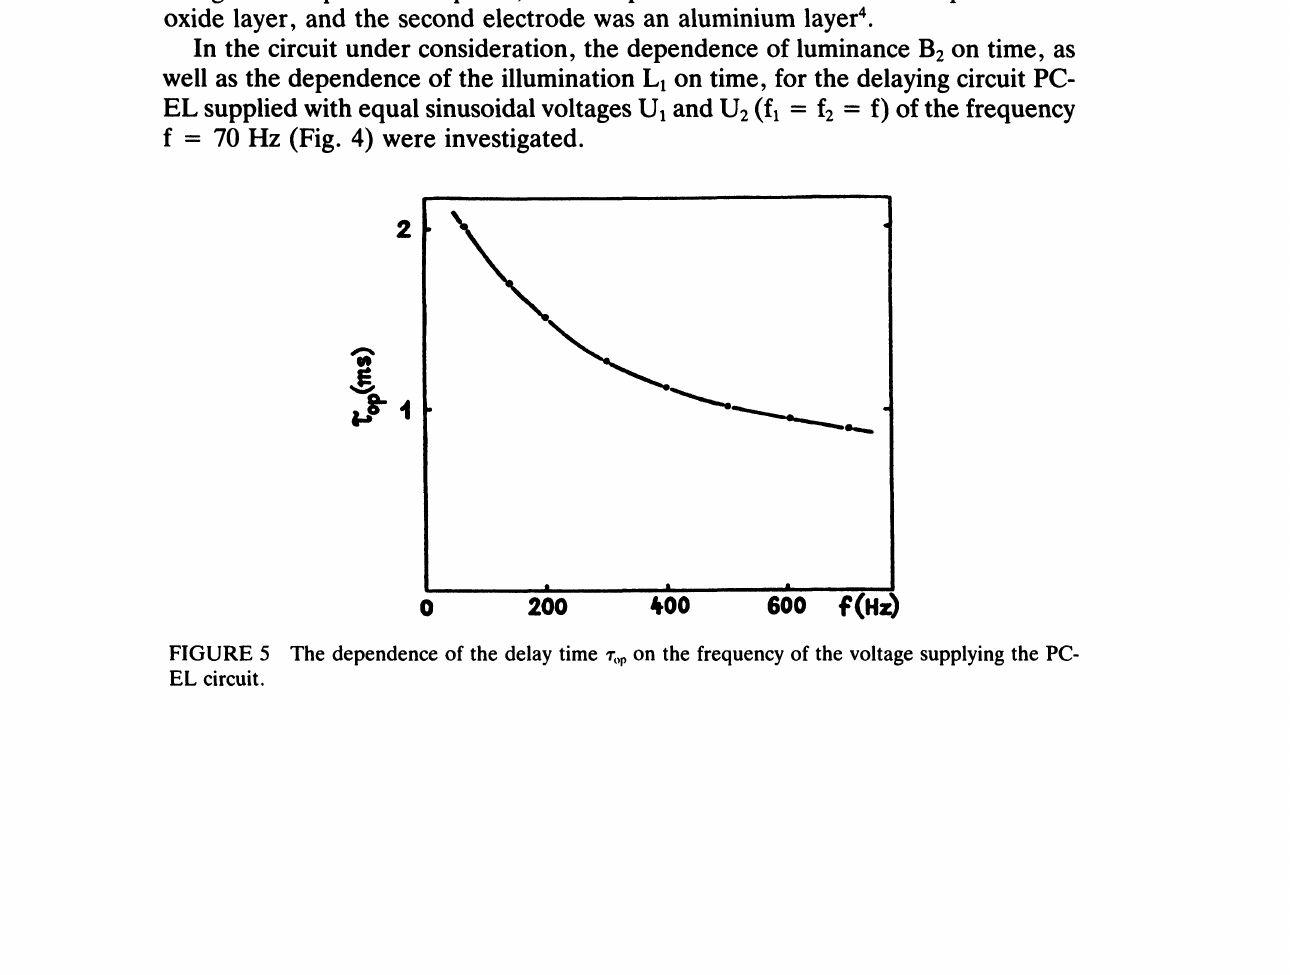
FIGURE 4 The dependence of luminance B2 and illumination L on time for the delaying circuit PC- EL supplied with equal sinusoidal voltages U U2 420 V of the frequency 70 Hz.